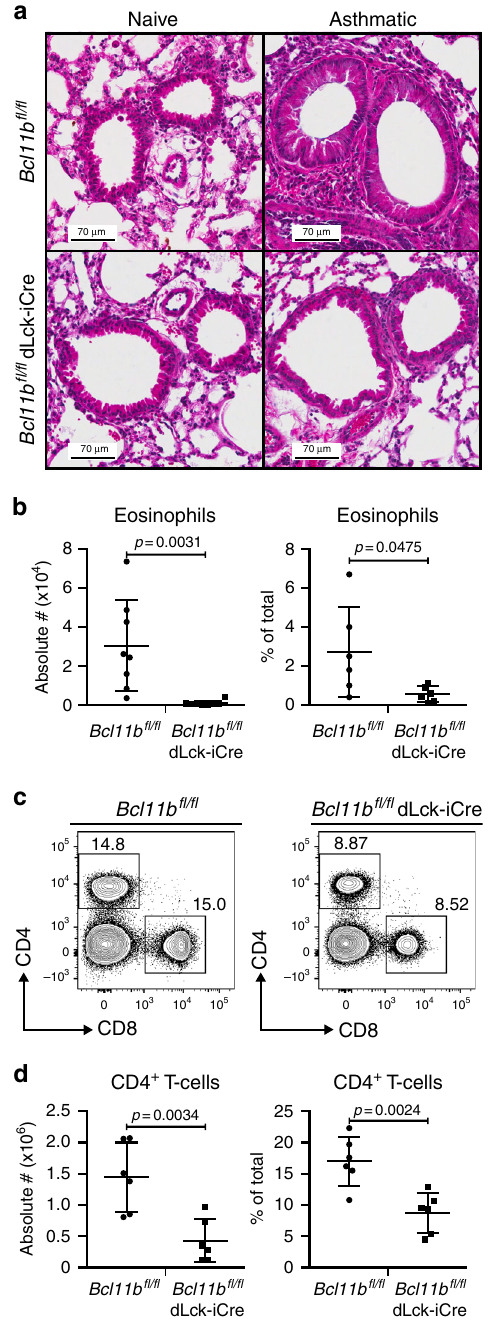
( n = 8) mice and Bcl11b fl / fl dLck-iCre ( n = 6) mice. Eosinophils